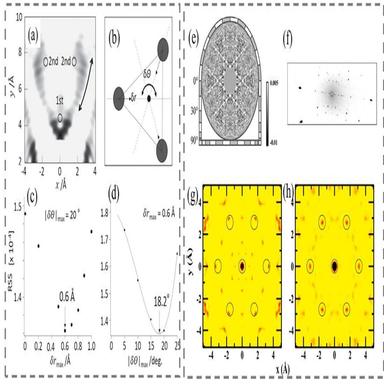
The SR-XFH measurements of LPSO phases: (a, b) calculated atomic image and description of the fluctuation of the Zn layer, where positional fluctuations are introduced; (c, d) residual sum of squares as a function of δrmax and |δ|max ; (e, f) a Y-Kα hologram of Mg99.7Y0.3 single crystal with the incident energy; (g, h) the atomic image around Y atom .